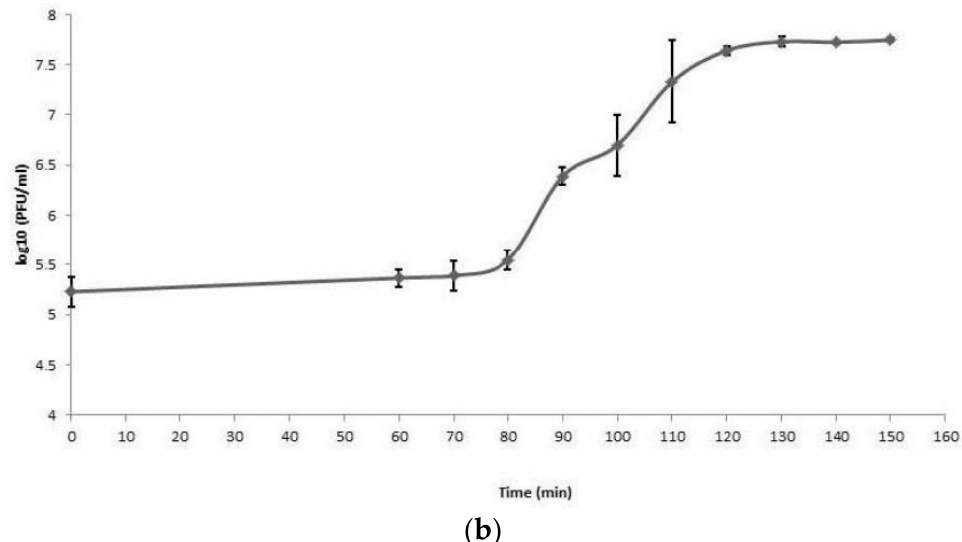
Figure 5. One-step growth curve of phages on K. pneumoniae Ni9. Phages were grown in an expo- nential phase culture of K. pneumoniae Ni9. Data points indicate the PFUs/mL at different time points. Each data point represents the mean of three independent measurements. ( a ) LASTA; ( b ) SJM3. 3.5. The Effect of Temperature and pH on Phage Stability The thermal point of inactivation for the phage LASTA is 68 ◦ C, and for SJM3 it is 69 ◦ C (Figure 6). Both phages were stable at a range of pH 5–11, and inactivated at pH 2 (Figure 7).